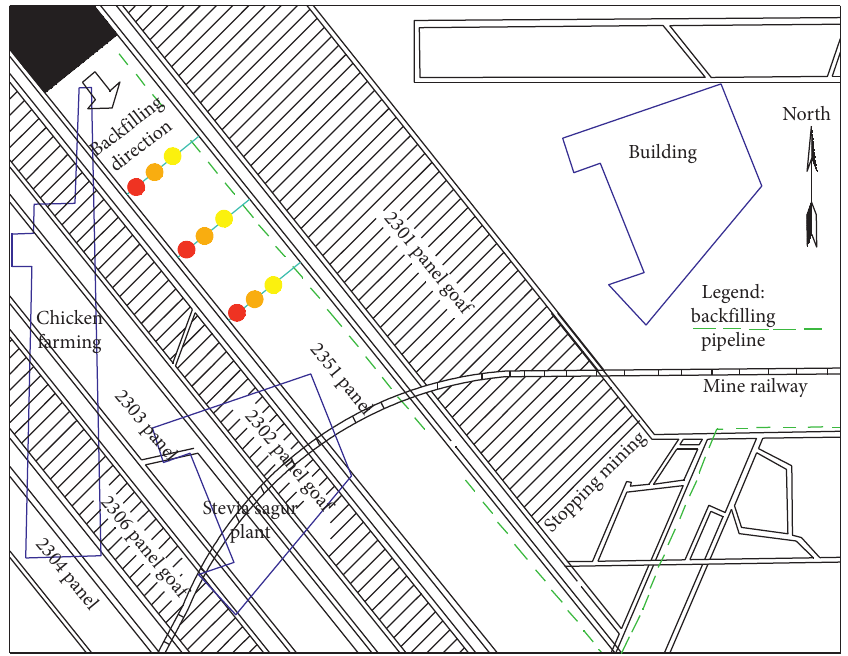
Figure 12: The field layout of the monitoring